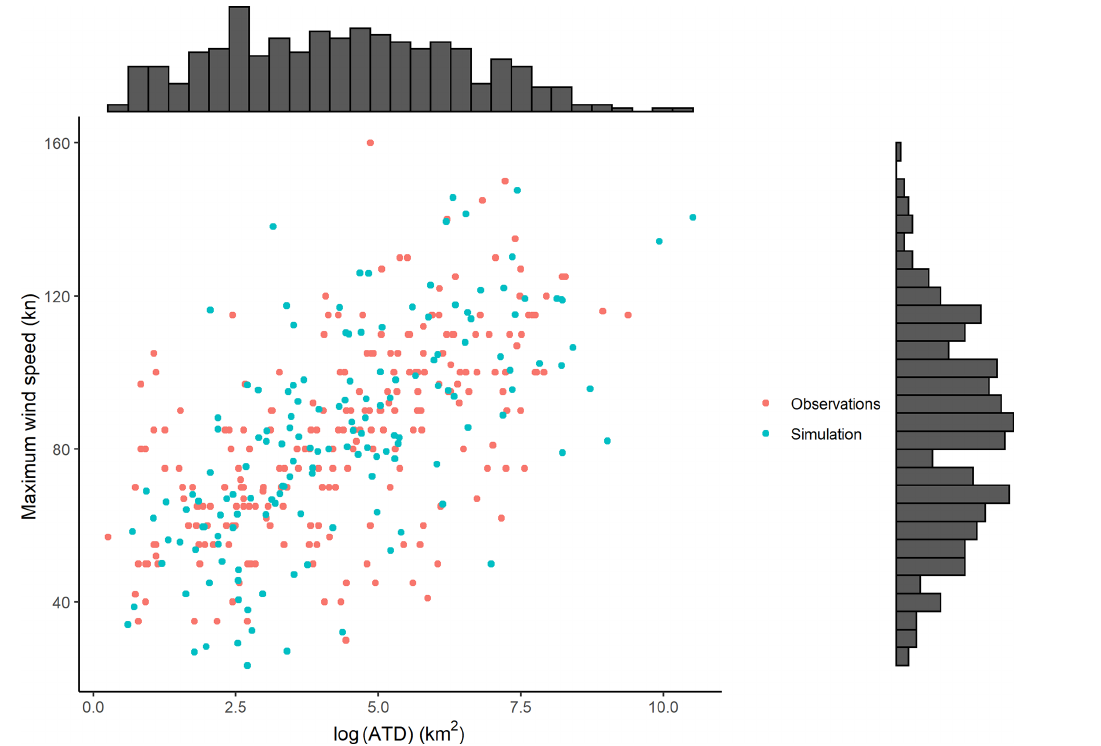
Figure 6. Observations and simulations from fitted Frank copula ( α = 4 . 91) with histograms combined of observations and simulations of maximum landfalling wind speed and log-transformed